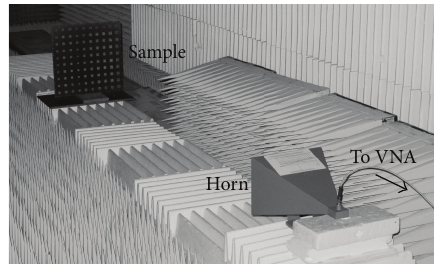
Figure8:Experimentalsetupformeasuringthespecularreflectance of the nonuniform surface sample under normal incidence.